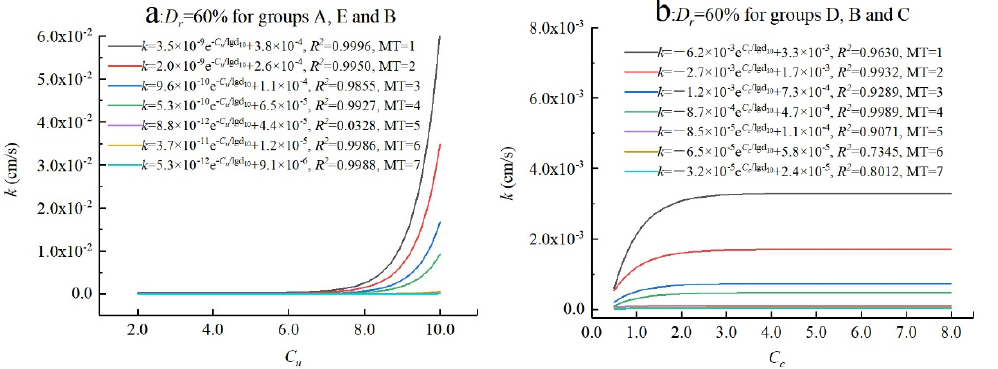
Figure 12. The reacquired curves for a wider range of Cu and Cc: ( a ) 2 < Cu < 10; ( b ) 0.5 < Cc < 8.